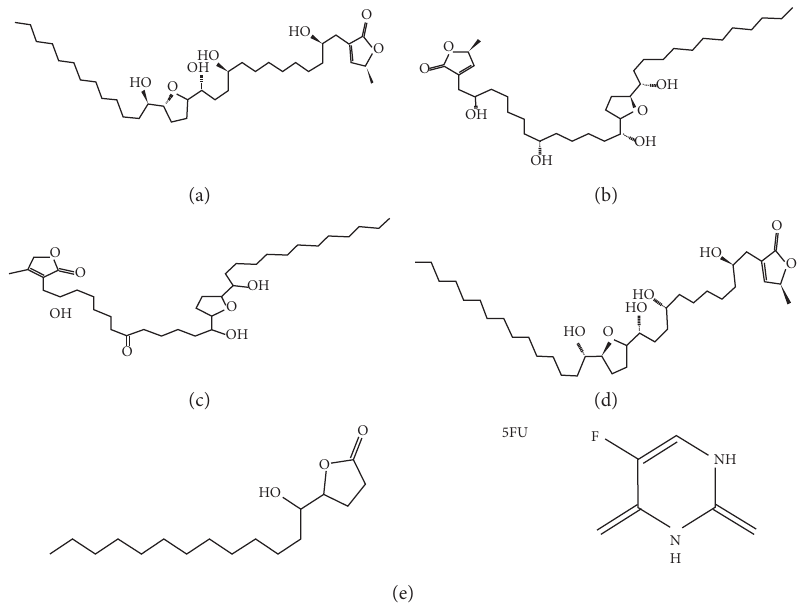
Figure 1: Schematic structure of the studied